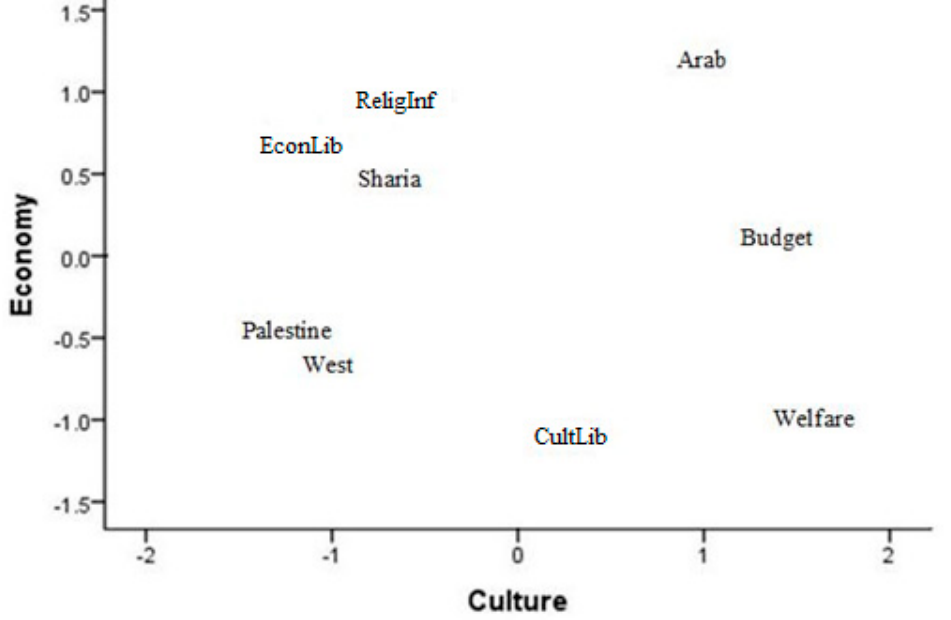
Figure 5. Jordanian political structures with respect to issues, 2013.